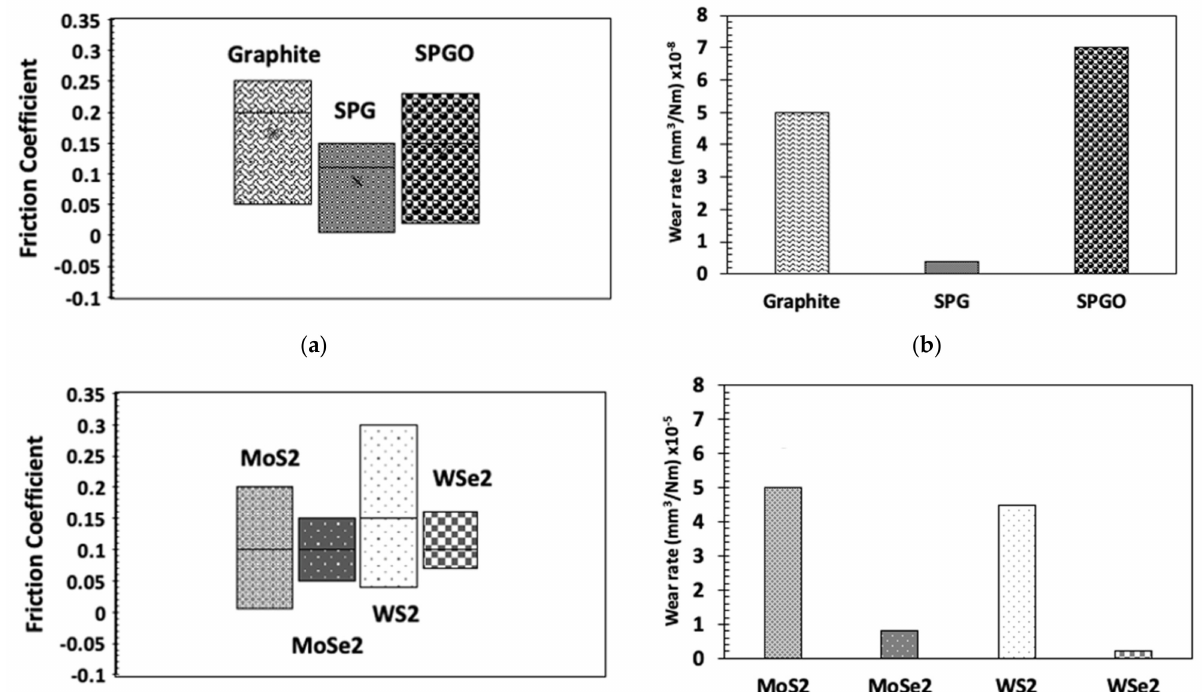
Figure 15. The range of friction coefficient and wear rate for carbon-based films and sputter-deposited transition metal sulfides and di-selenides films: ( a ) Friction coefficient range for carbon-based films; ( b ) Wear rate range for carbon-based film; ( c ) Friction coefficient range for sputter-deposited transition metal sulfides and di-selenides films; and ( d ) Wear rate range for sputter-deposited transition metal sulfides and di-selenides films